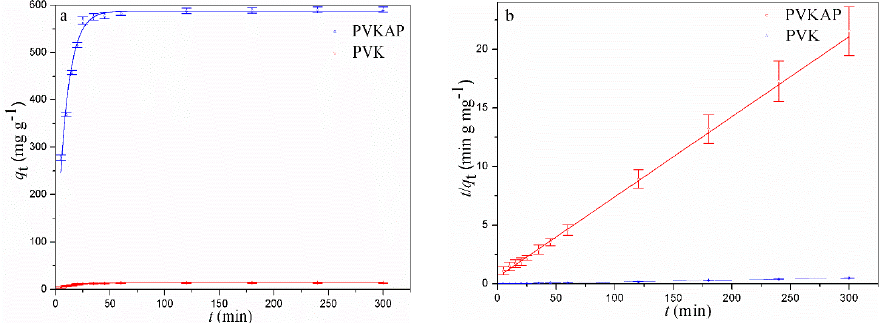
Figure 5. The influence of the adsorption reaction time of uranyl on PVK and PVKAP. ( a ) pseudo-first-order ( b ) pseudo-second-order.